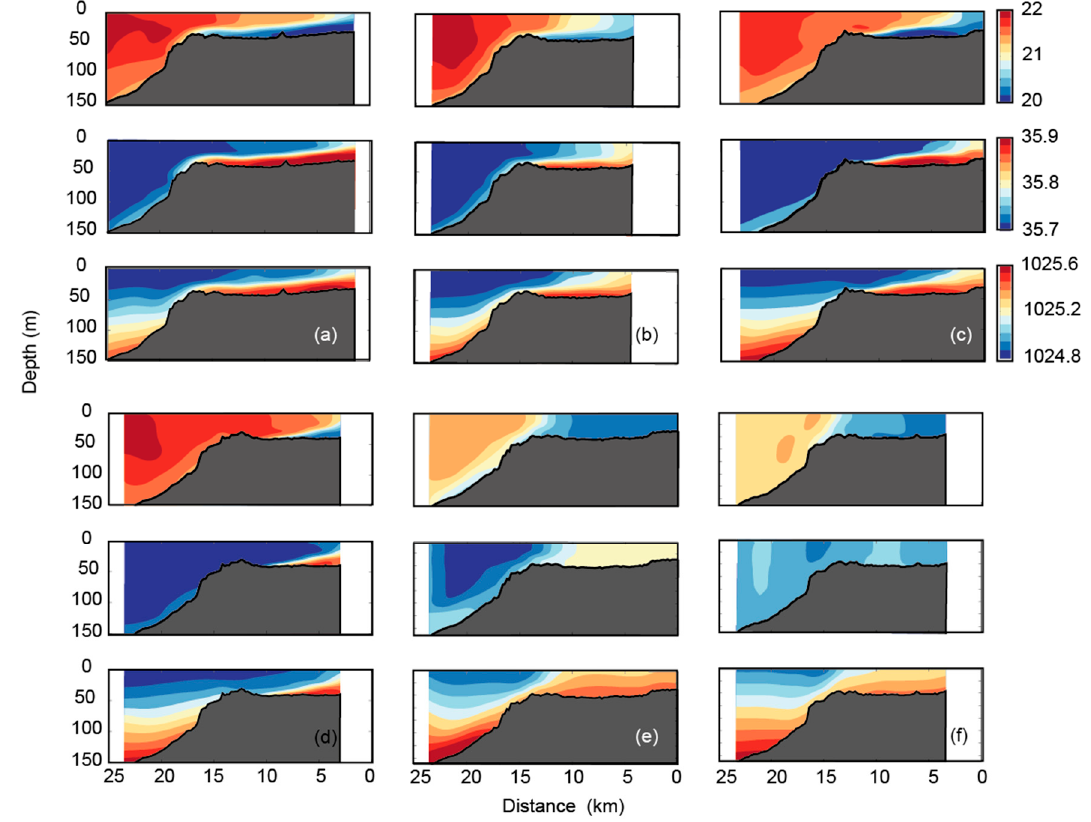
Figure 15. Temperature ( ◦ C), salinity (psu), and density (kg/m 3 ) along the Two Rocks transect